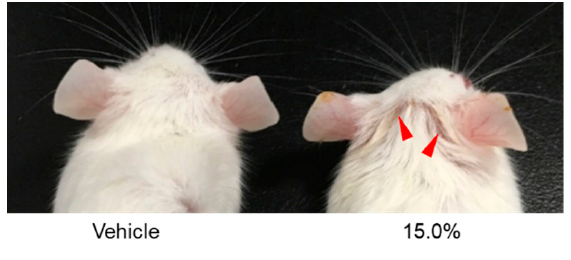
Figure 4. Ear inflammation induced by Brazilian green propolis (BGP). Vehicle or 15.0% ( w / v ) BGP was applied to the back of the ears of mice for 3 consecutive days for LLNA. In LLNA, all mice treated with 15.0% ( w / v ) BGP showed obvious ear inflammation at day 5 from the first exposure. The photos show the typical ears of control mouse (Vehicle; left photo) and inflamed mouse (15.0% BGP; right photo), respectively. Red arrowheads indicate the inflammatory response.